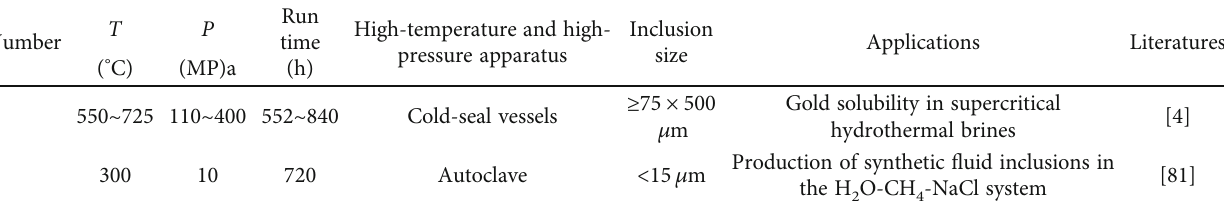
Table 2: Some typical applications of the preablating FIS